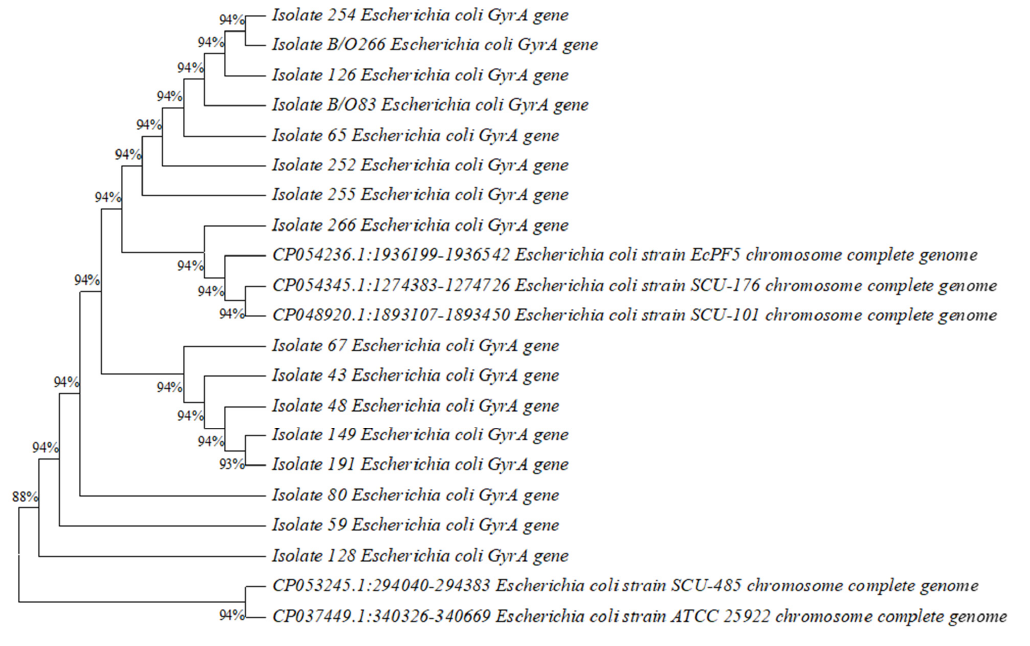
Figure 1. Phylogenetic tree based on DNA gyrase A ( gyr A ) sequences illustrating the evolutionary distance between 16 isolates of Escherichia coli from 14 mothers and 2 neonates and 5 strains of Escherichia coli with known pathotypes.